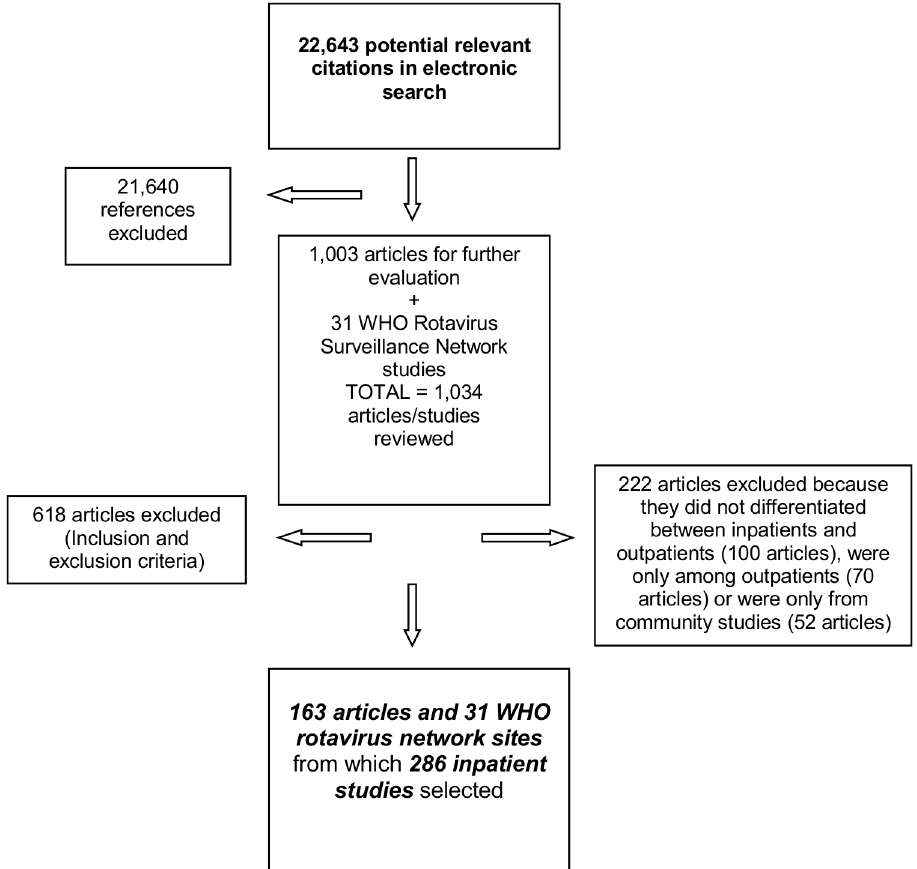
Figure 1. PRISMA Flow Diagram of studies included.